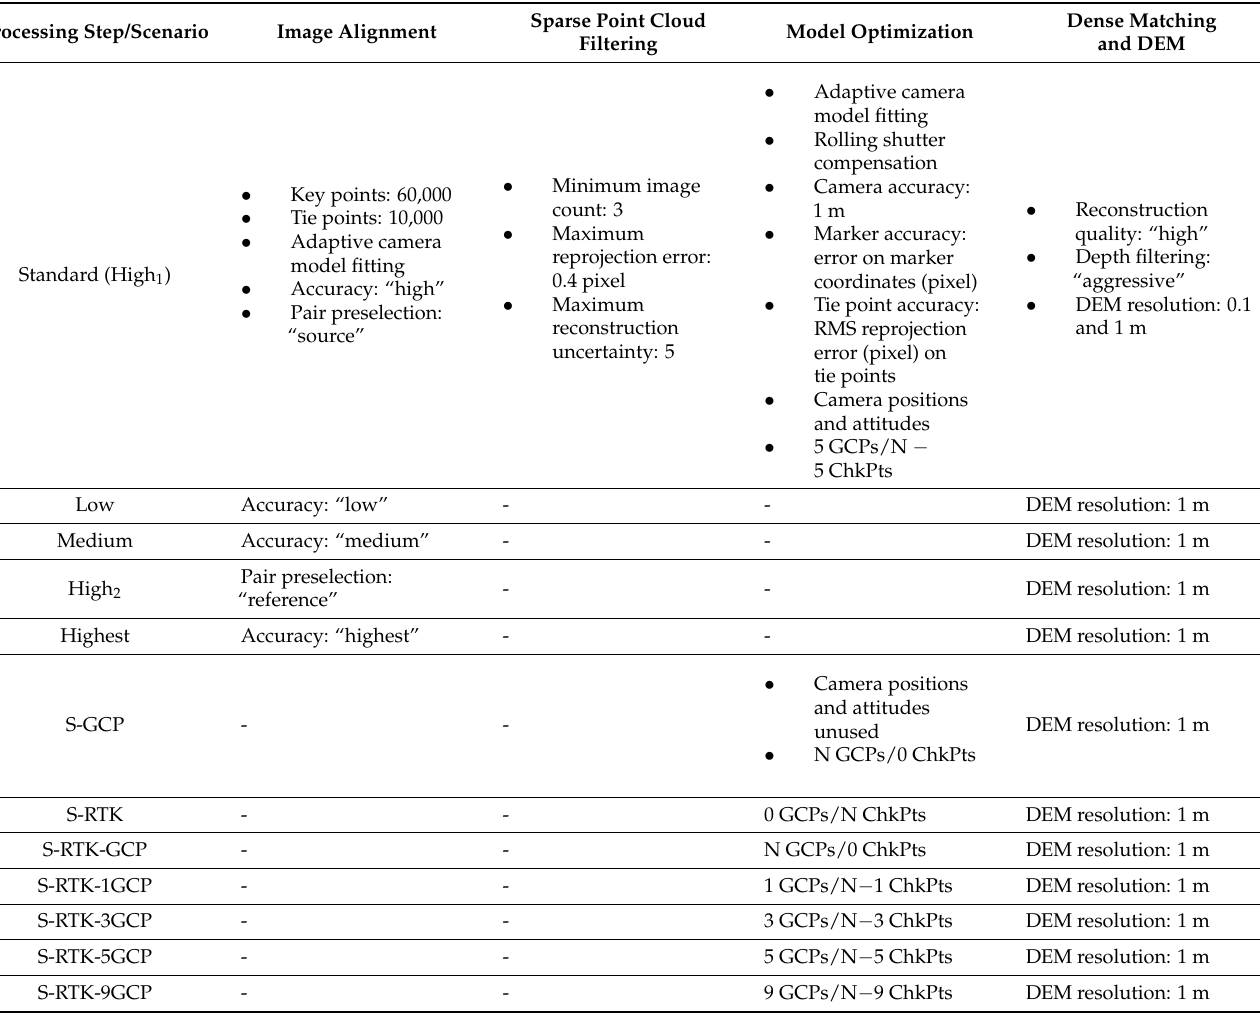
Table 2. Overview of the processing parameters and scenarios used for DEM reconstruction with Agisoft